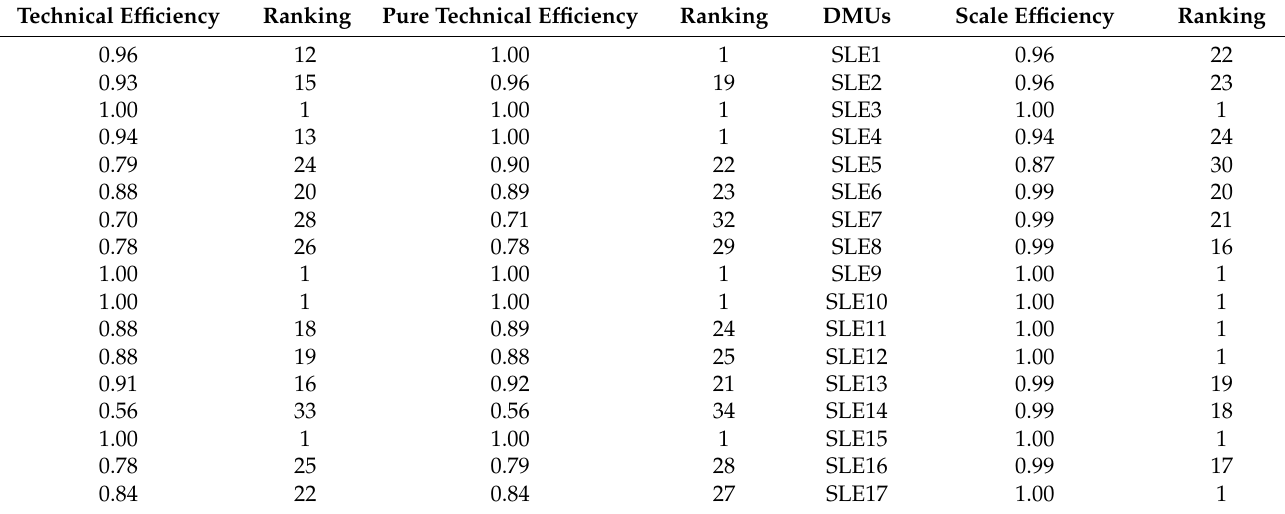
Table A6. Technical efficiency, pure technical efficiency, and scale efficiency for 34 listed LED energy enterprises in